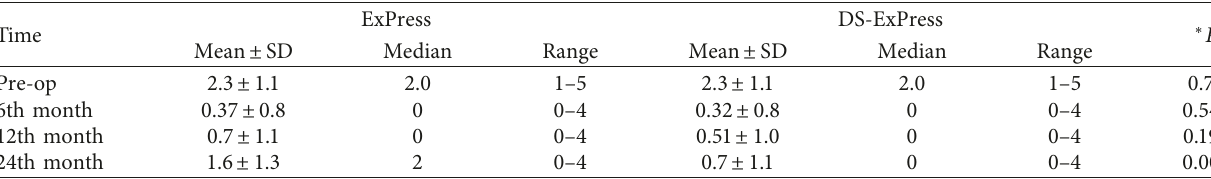
Table 4: Amount of hypotensive drugs: mean values, median values, standard deviations, and range in the Ex-Press device implantation (ExPress) and Mermoud’s ExPress modification (DS-ExPress) groups at specific times after surgery. ExPress Time